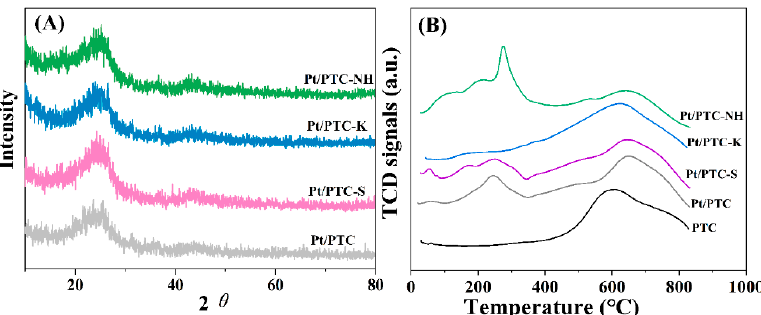
Figure 3. ( A ) XRD patterns and ( B ) H 2 -TPR curves of the Pt catalysts over the functional PTC supports.